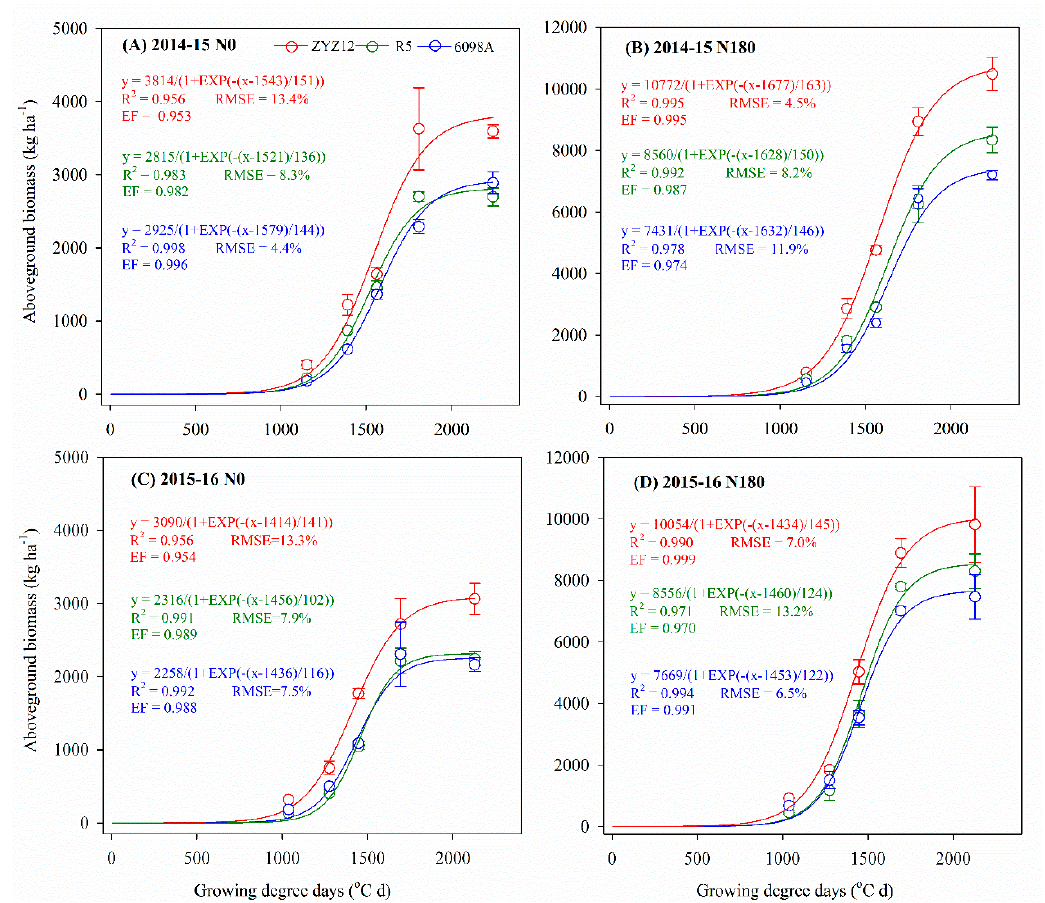
Figure 2. Dynamics of the measured and simulated values of aboveground biomass in three oilseed rape cultivars under 0 and 180 kg ha − 1 N supply in the 2014–2015 ( A , B ) and 2015–2016 ( C , D ) seasons.